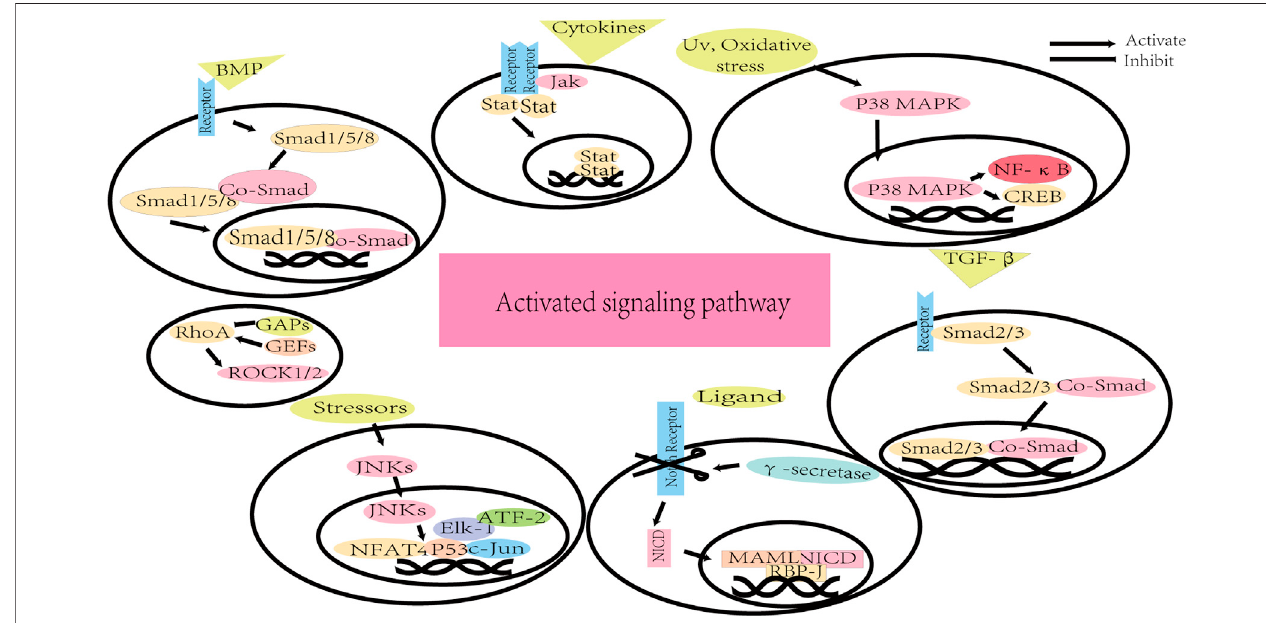
FIGURE 4 | The background information of activated signaling